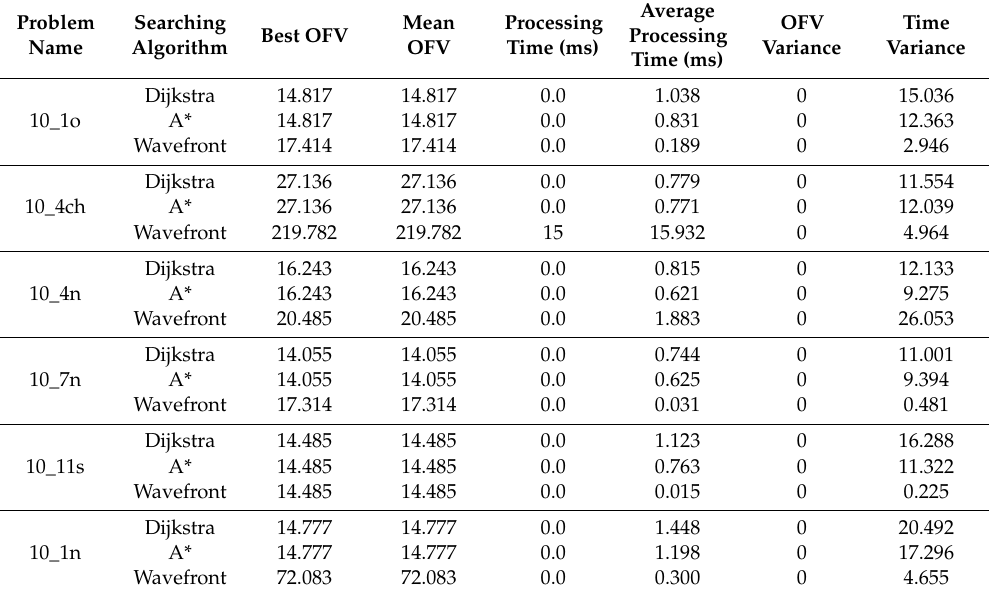
Table 11. Experimental results of the other algorithms within 10 × 10